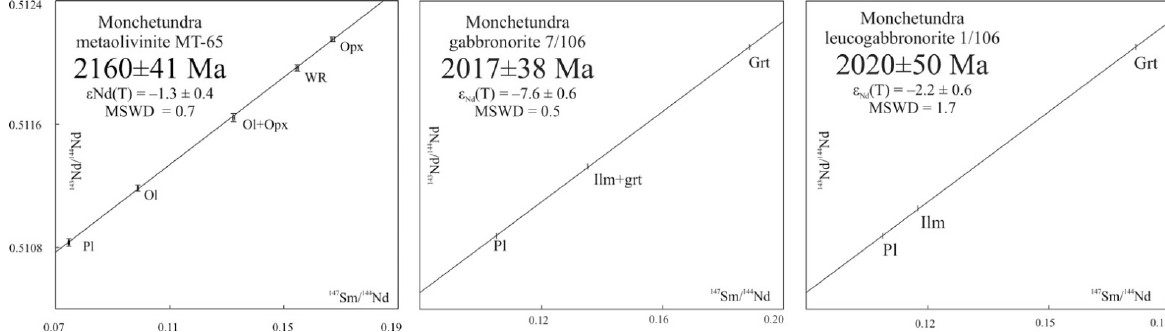
Figure 10. Mineral Sm-Nd isochrones for rocks of the Monchetundra massif. Table 2. Sm-Nd data for rocks and minerals of Monchegorsk Complex. Dunites and chromitite interlayers are dated in the Sopcheozero deposit. The Sm- ε Nd(T) = +2.3 ± 0.5. Meanwhile the distinctive features of chromitites from the